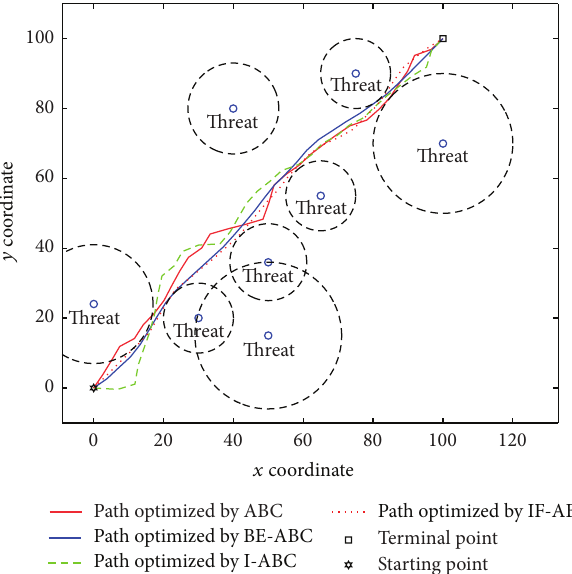
Figure 9: Comparative path planning results optimized by different ABC relevant algorithms in Case 3 ( 𝐷 = 30 and MCN = 1000 ).